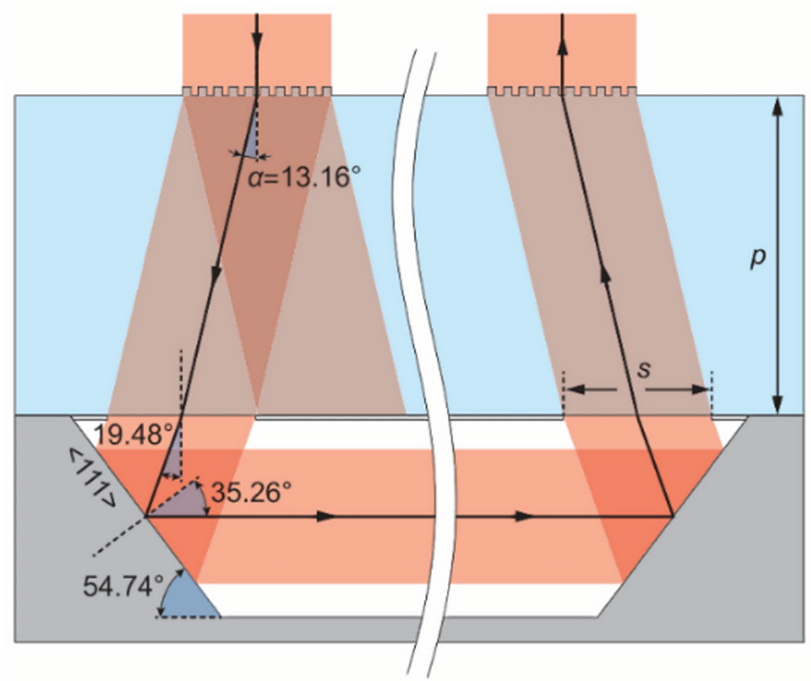
Figure 10. Routing of the beam in the cell. Reprinted from Ref [54].